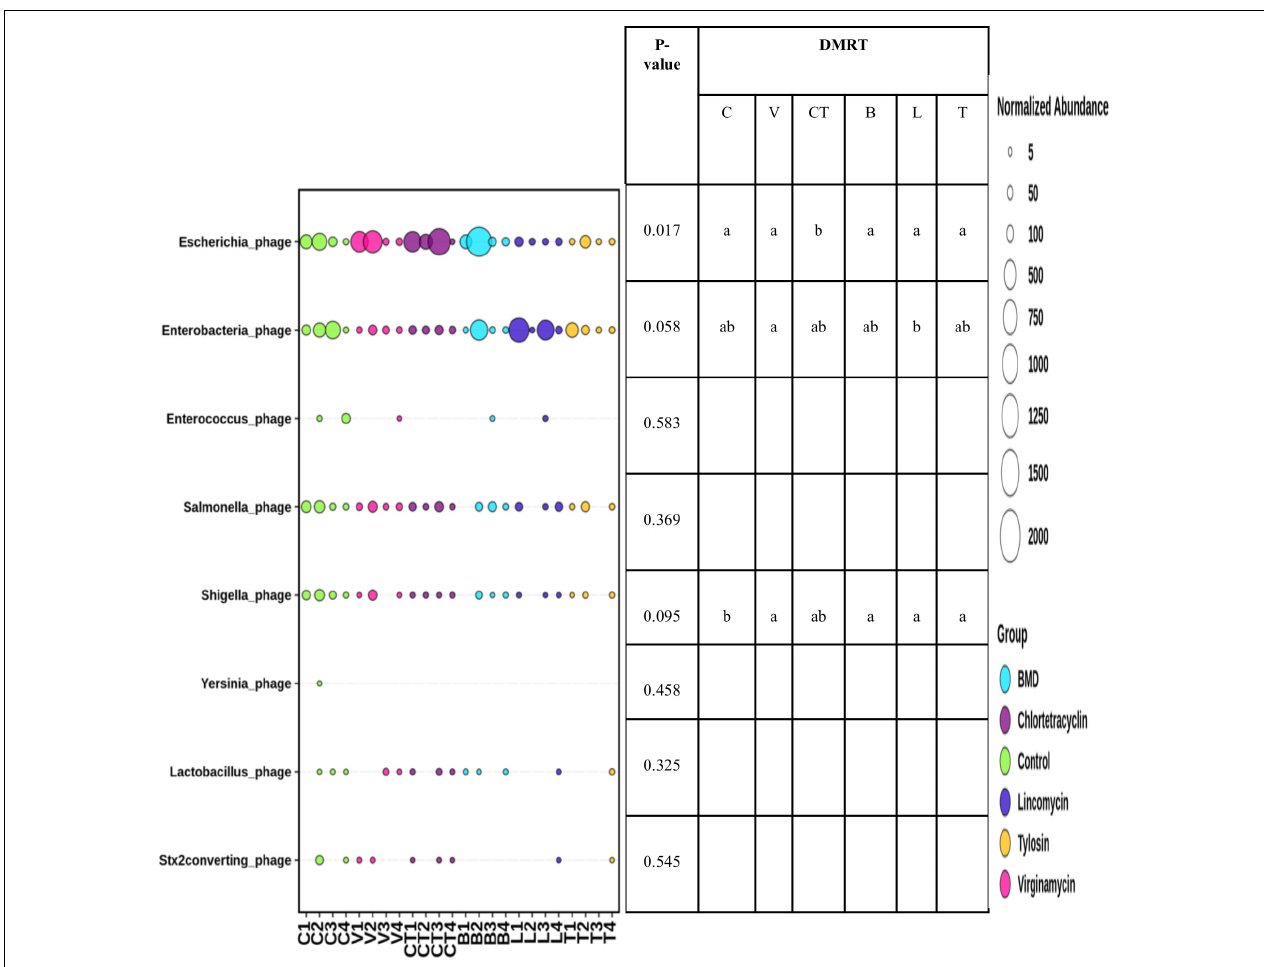
FIGURE 6 | Differential abundance of gut bacteriophages in different groups. The size of the bubbles in the bubble plot indicates the normalized (normalized to per million reads) abundance.